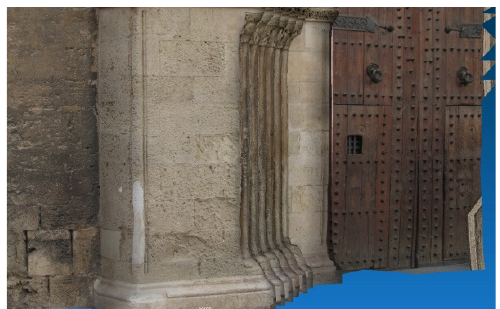
Figure 11: Projection of one image onto the constrained mesh After all individual images have been processed; the partial models created are imported into 3DStudio Max . In this software, via a texture rendering process, which is based on a projection that is defined between the partial models and the constrained mesh, the texture of the original images is transferred to the texture map of the constrained mesh. In this respect a number of partial texture maps are created and all are later combined and blended into Adobe Photoshop